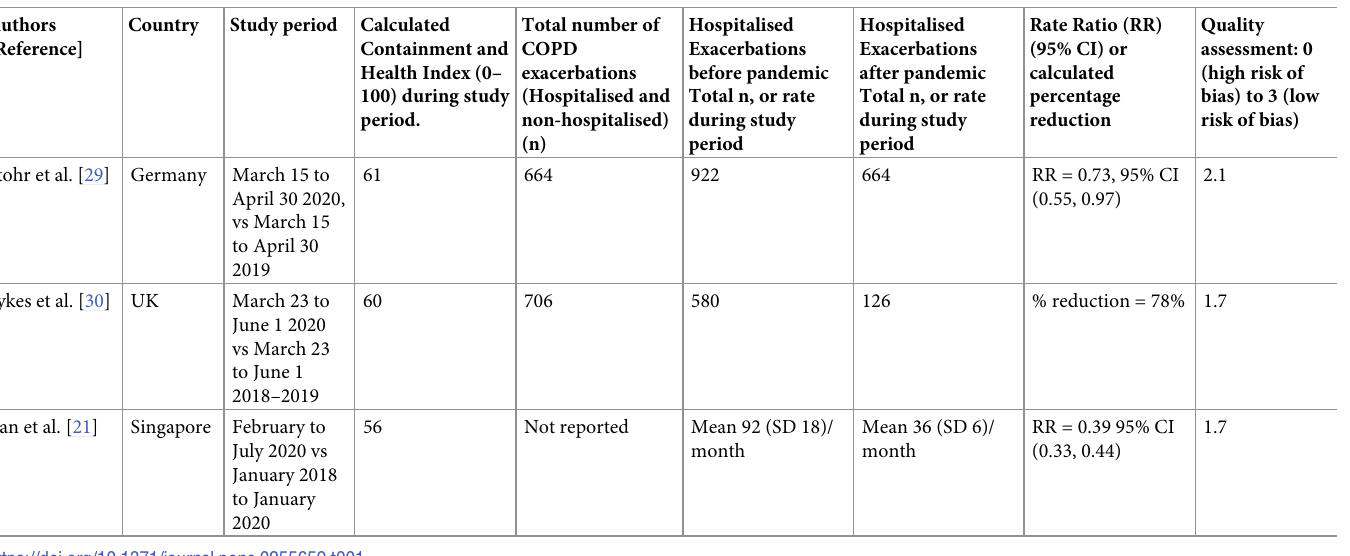
viral infections in exacerbations admissions was reduced at 0.35, 95% CI (0.22 to 0.53, p < 0.001). Huh et al. [22] assessed hospitalisations due to pneumonia or influenza in those with pre-existing COPD and found a reduction in both conditions during the pandemic compared to the pre-pandemic period, rate ratio (95% CI): 0.54 (0.53–0.55) and 0.27 (0.24–0.30) respectively. In Hong Kong, a reduction in the number of influenza A or B viruses in people with COPD was observed during the pandemic compared with pre-pan- demic period (monthly average: 1888 vs 3958 respectively) [23]. The reduction was associ- ated with a decrease in exacerbations.